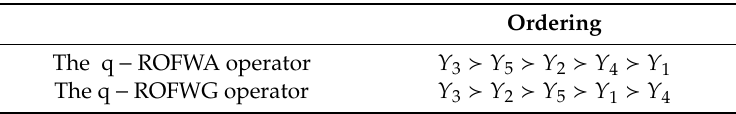
Table 8. The ordering of Y i ( i = 1,2,3,4,5 )